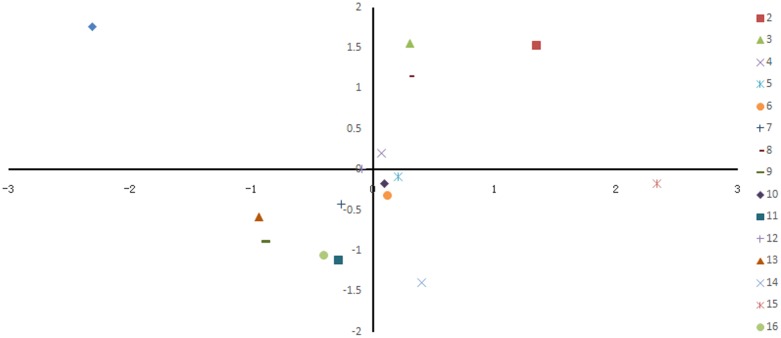
Principal coordinate analysis of 16 samples based on denaturing gradient gel electrophoresis fingerprinting. Points of different colors or shapes represent different samples, the distance among the samples indicated the similarity of bacteria in intestinal different sections of hens.